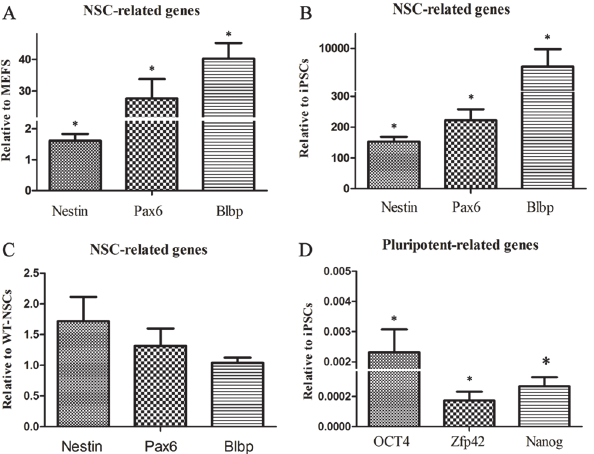
Fig 5. QRT-PCR analysis of iNSCs. QRT-PCR revealed that expression of typical NSC-related genes dramatically increased on the 7th day of induction compared to MEFs (A) and iPSCs (B) with negligible expression of pluripotency-related genes (D). Furthermore, iNSCs were similar to wt-NSCs in terms of expression of NSC-specific genes